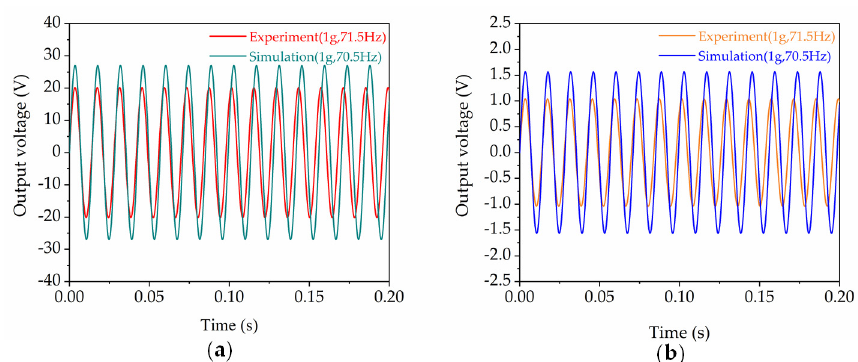
Figure 5. Comparison of a time-domain diagram of the experimental and simulation results of the output voltage of one HEH module: ( a ) PEG; ( b ) EMG.